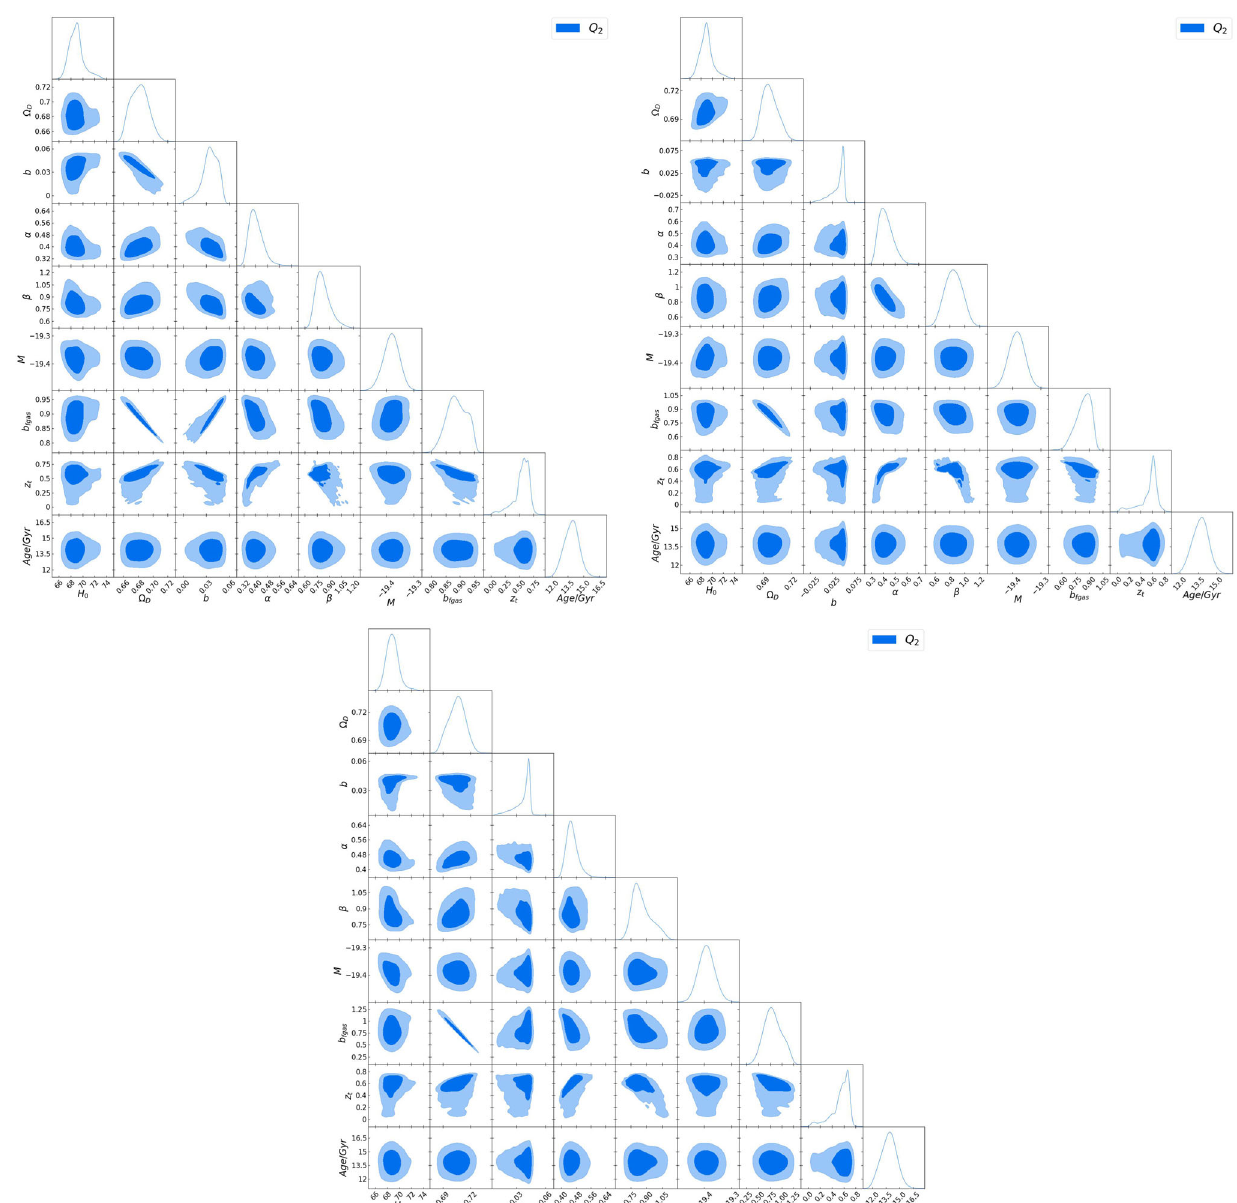
Fig. 9 The contour maps of the EHRDE (see Eqs. (21) and (22)) with three types of linear interaction Q 1 , Q 2 and Q 3 listed in Table 1. In this figure H 0 is the Hubble parameter, (cid:5) D is the dark energy density, α and β are the dimensionless parameters, b is the coupling constant, M is